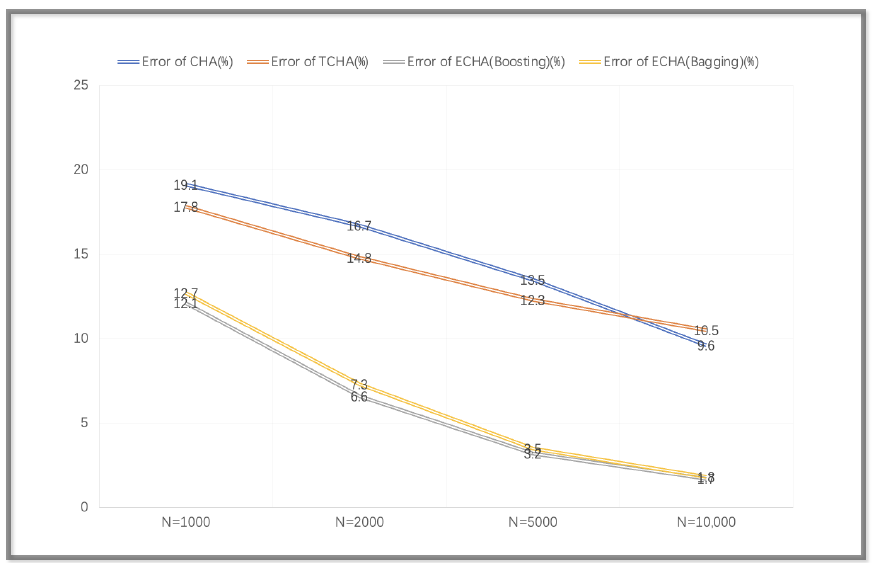
Figure 5. The error rates of different classifiers for the 3-qubit case when N increased. The perfor- mances of the two ECHAs were better than the CHA, while those of the ECHAs were similar.